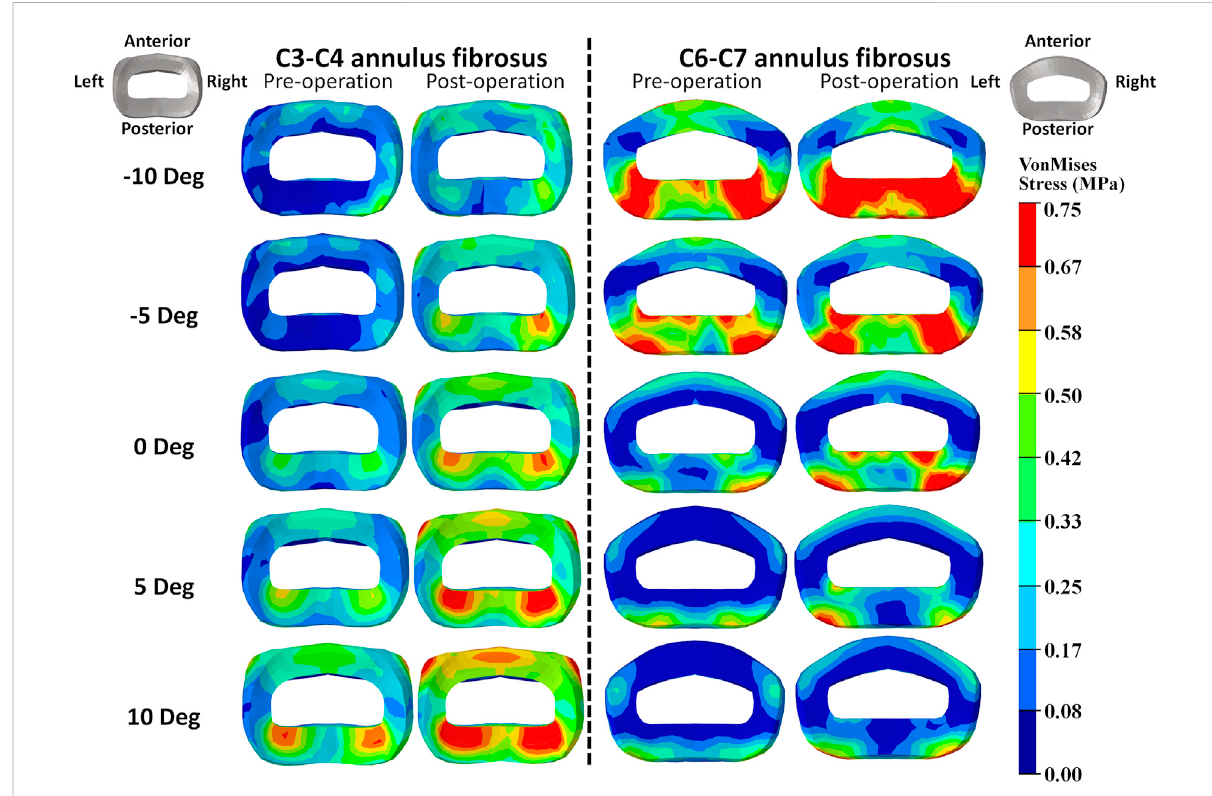
FIGURE 5 Annulus fi brosus VonMises stress distribution of C2 – T1 pre- and postoperative FE models with different T1 tilts under 15 ° extension loading.